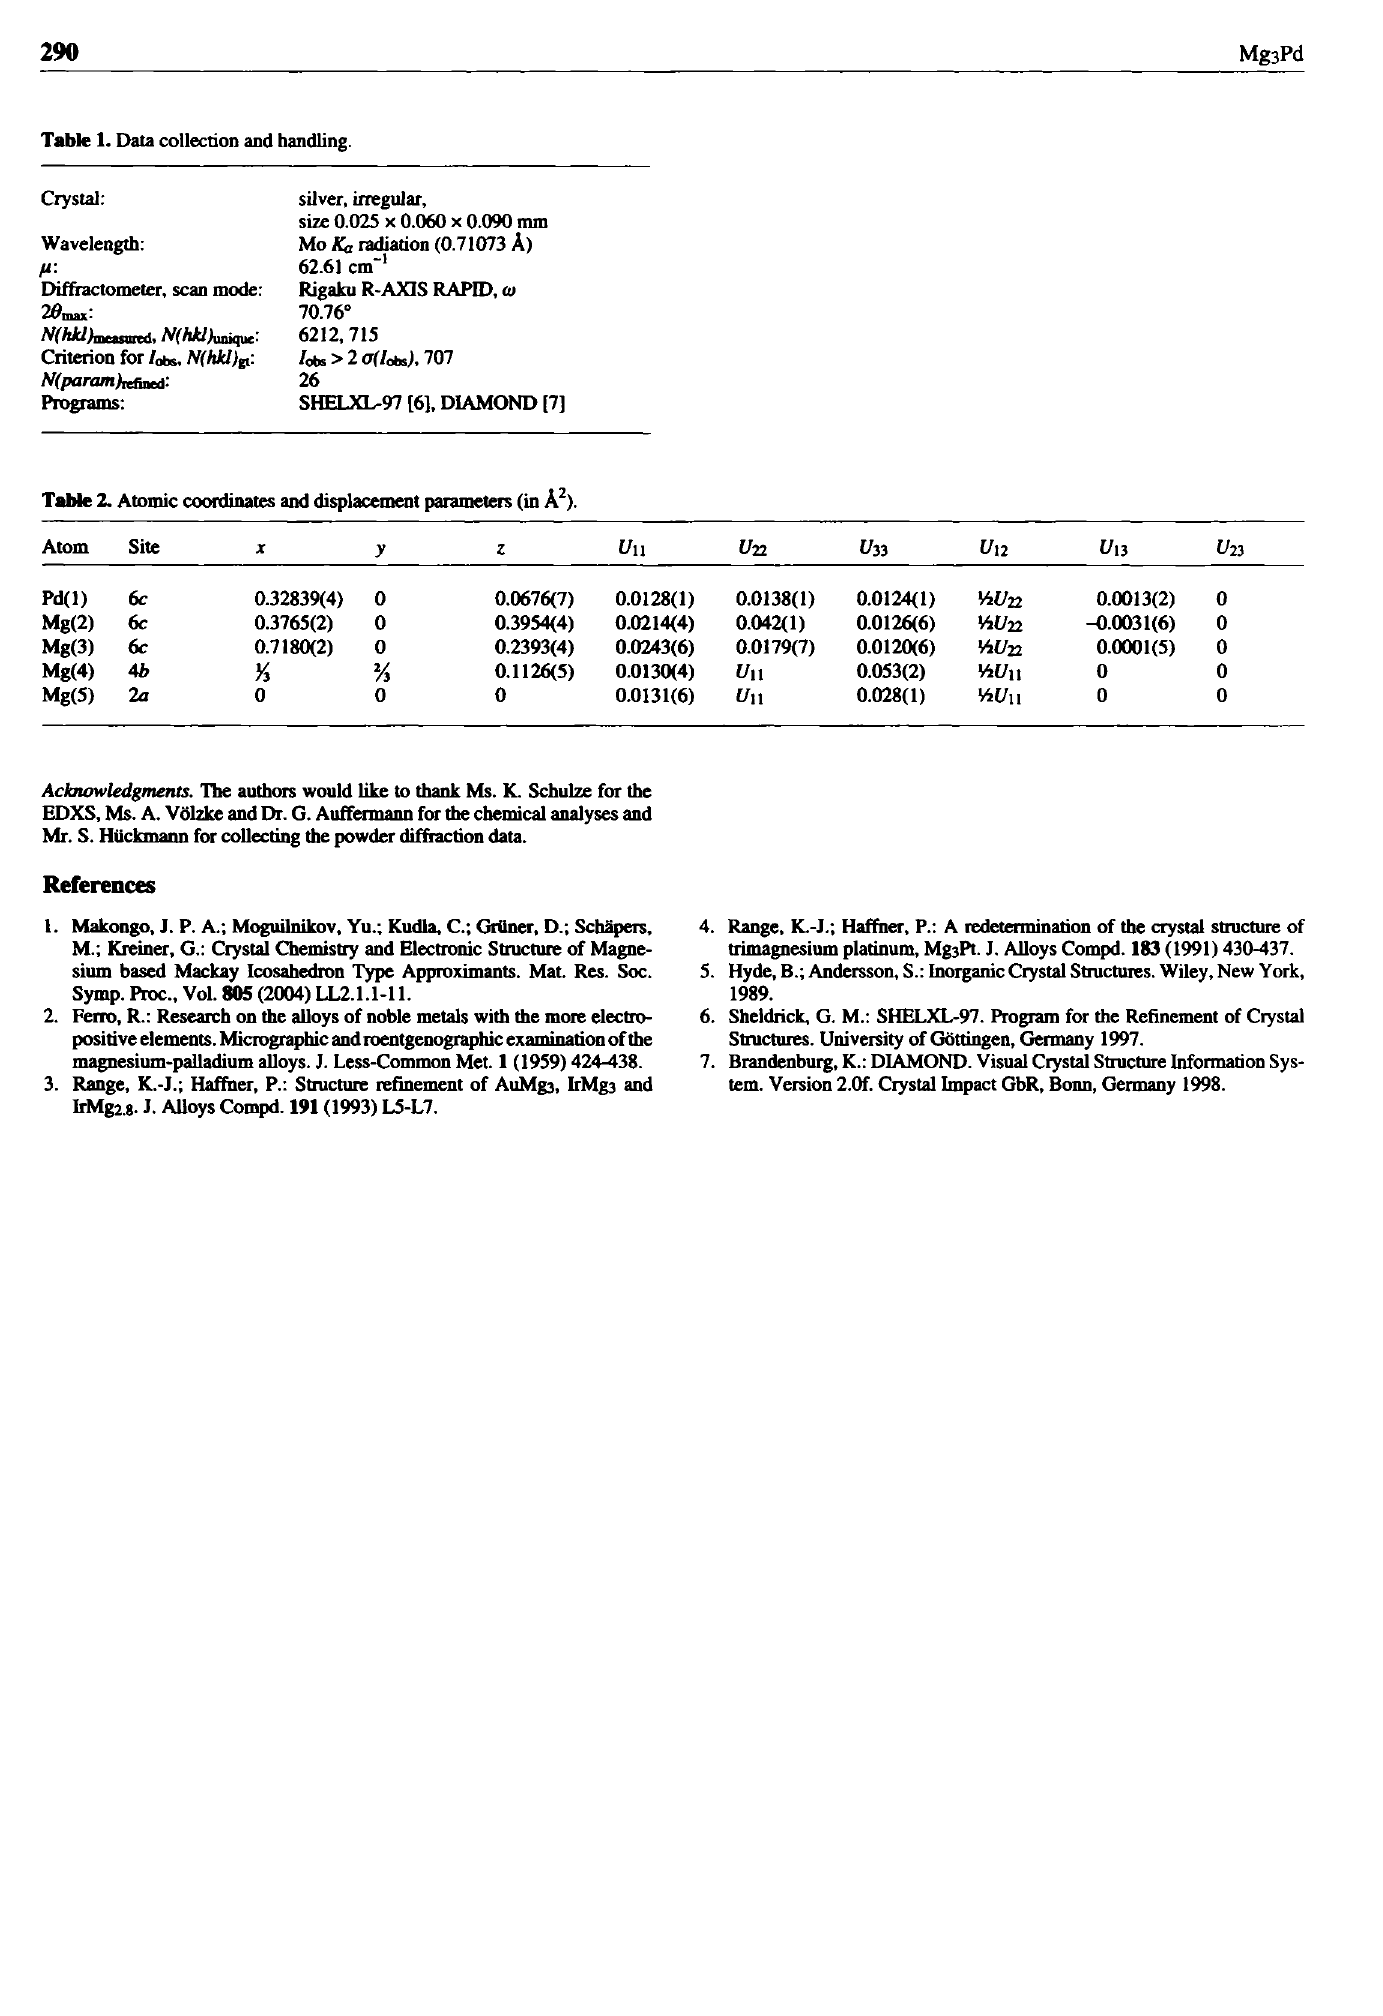
Table 1. Data collection and handling.